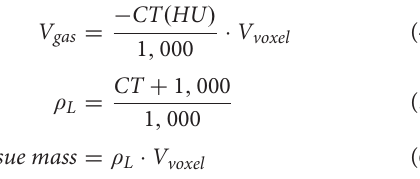
6,000 different convolution kernels used. This took about 1.4